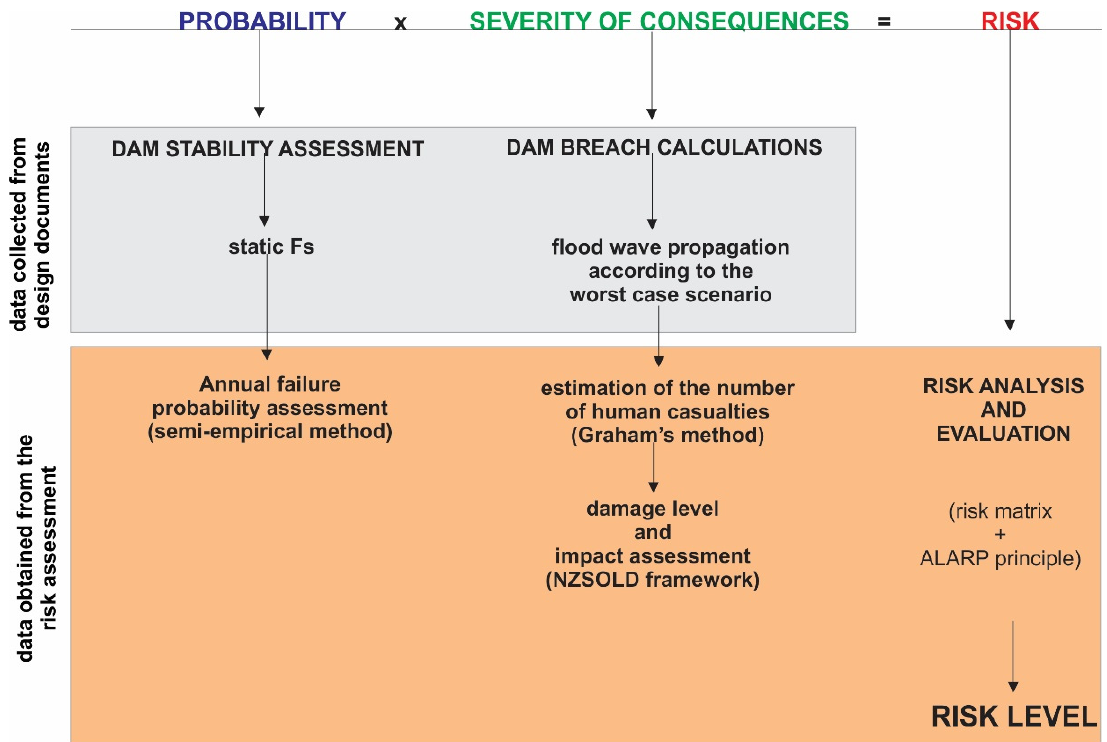
Table 4. Determination of potential impact by [30] is licensed under CC BY